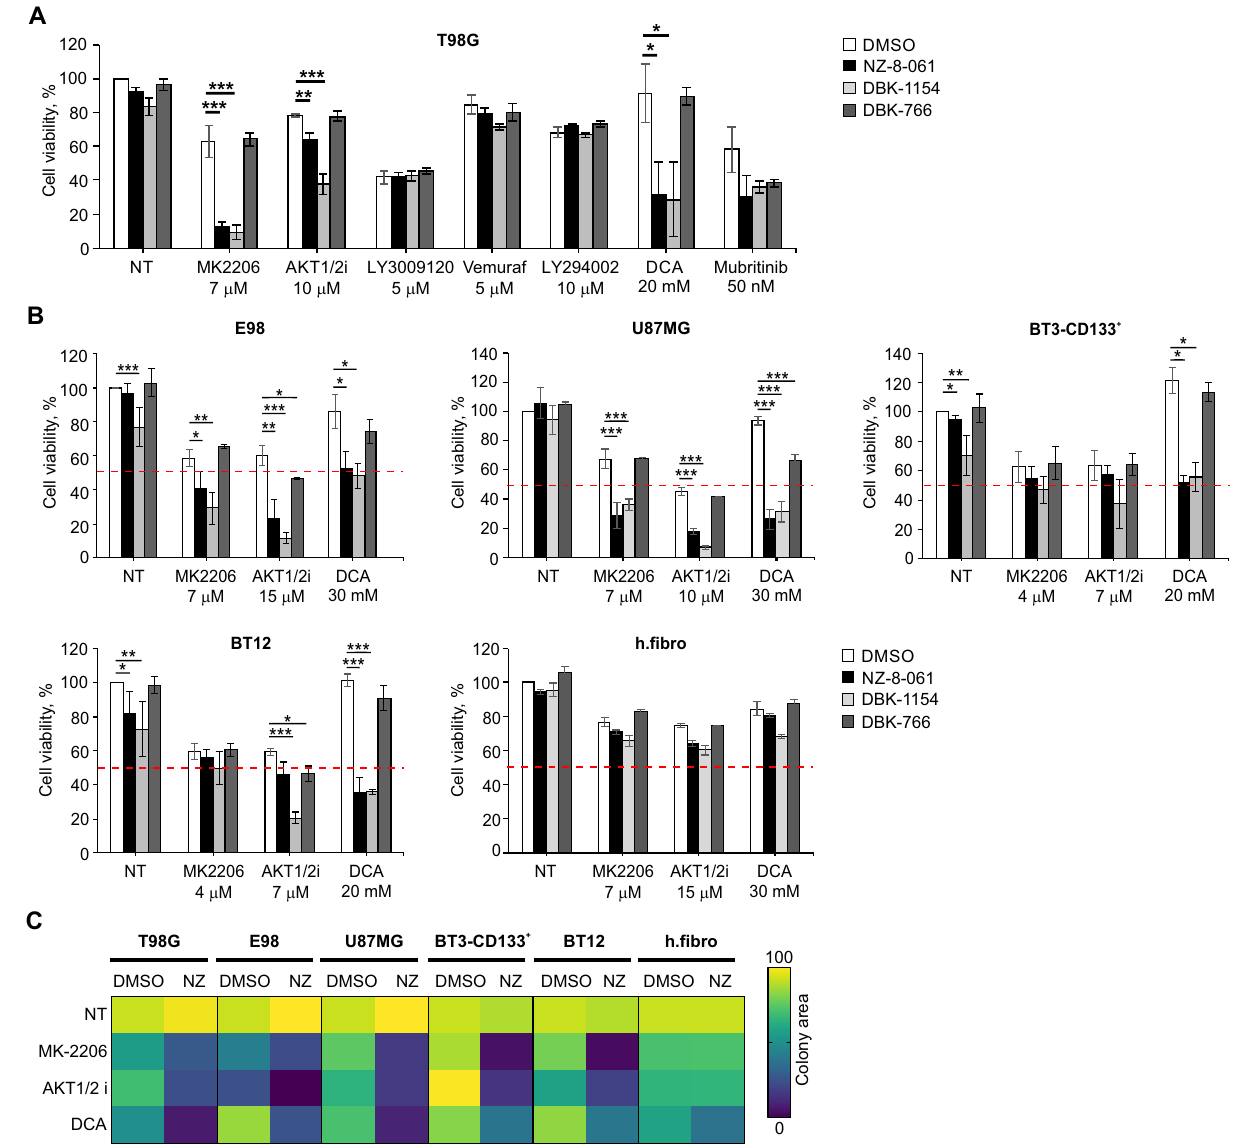
Figure 4. Exploration of AToMI results in heterogeneous GB cell lines. ( A , B ) Viability of T98G ( A ) and established GB, E98 and U87MG, and patient-derived GSCs, BT3-CD133 + and BT12, cell lines ( B ) treated with the selected kinase inhibitors alone or in combination with 8 µM NZ-8-061, 6 µM DBK-1154 or 10 µM DBK- 766 for 72 h. Human fibroblasts were used as a control of normal cells. Data as mean ± SD (n = 3 independent experiments). * p < 0.05, ** p < 0.01, *** p < 0.001 by Student’s t -test. Red striped line indicates 50% inhibition of cell viability which is considered as a cytostatic but not cytotoxic response. ( C ) Heat map representation of quantified colony growth assay data in the indicated established GB cell lines, patient-derived GSCs under vehicle (DMSO) or 8 µM NZ-8-061 (NZ) treatment either alone or in combination with indicated kinase inhibitors. Human fibroblasts used as a control of normal cells. (n = 2 independent